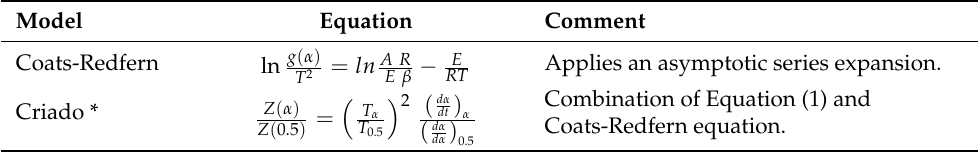
Table 5. Non-isoconversional models. (Mumbach et al. (2019) [20], Aboulkas et al. (2010) [17]).